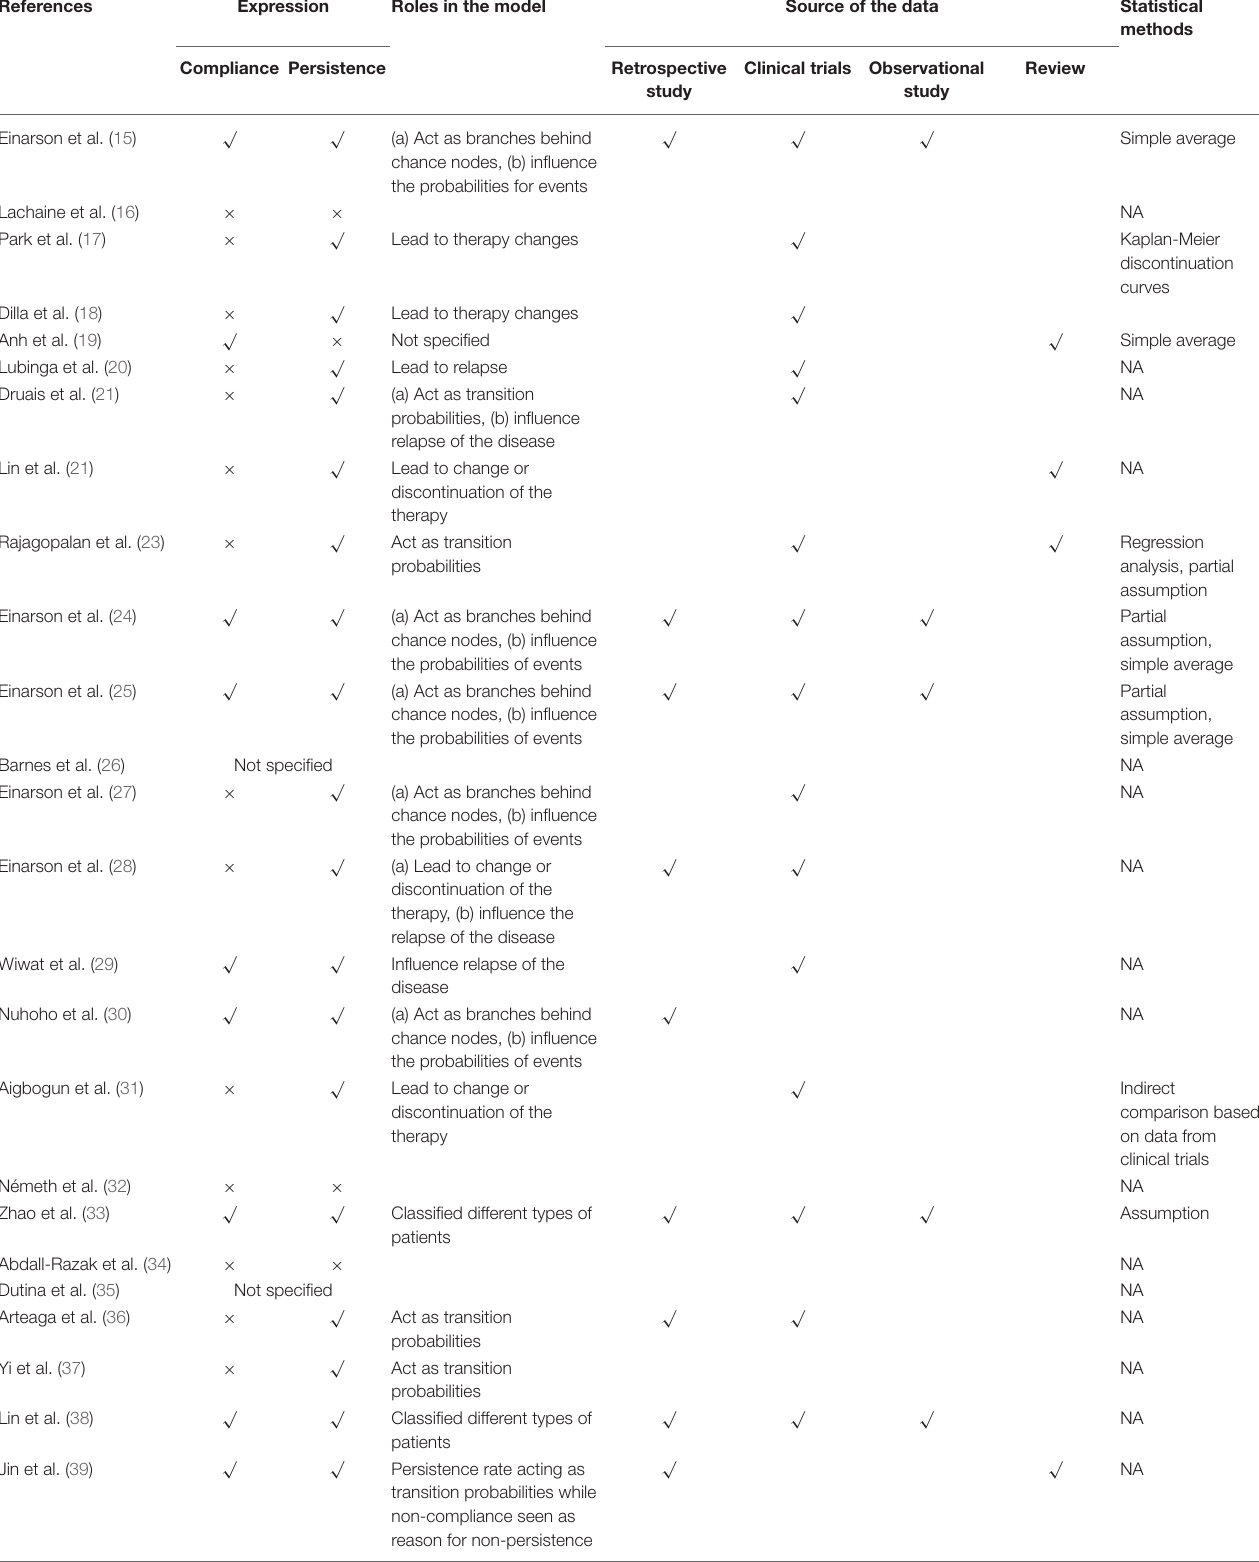
TABLE 5 | Summary of the methods used to integrate medication